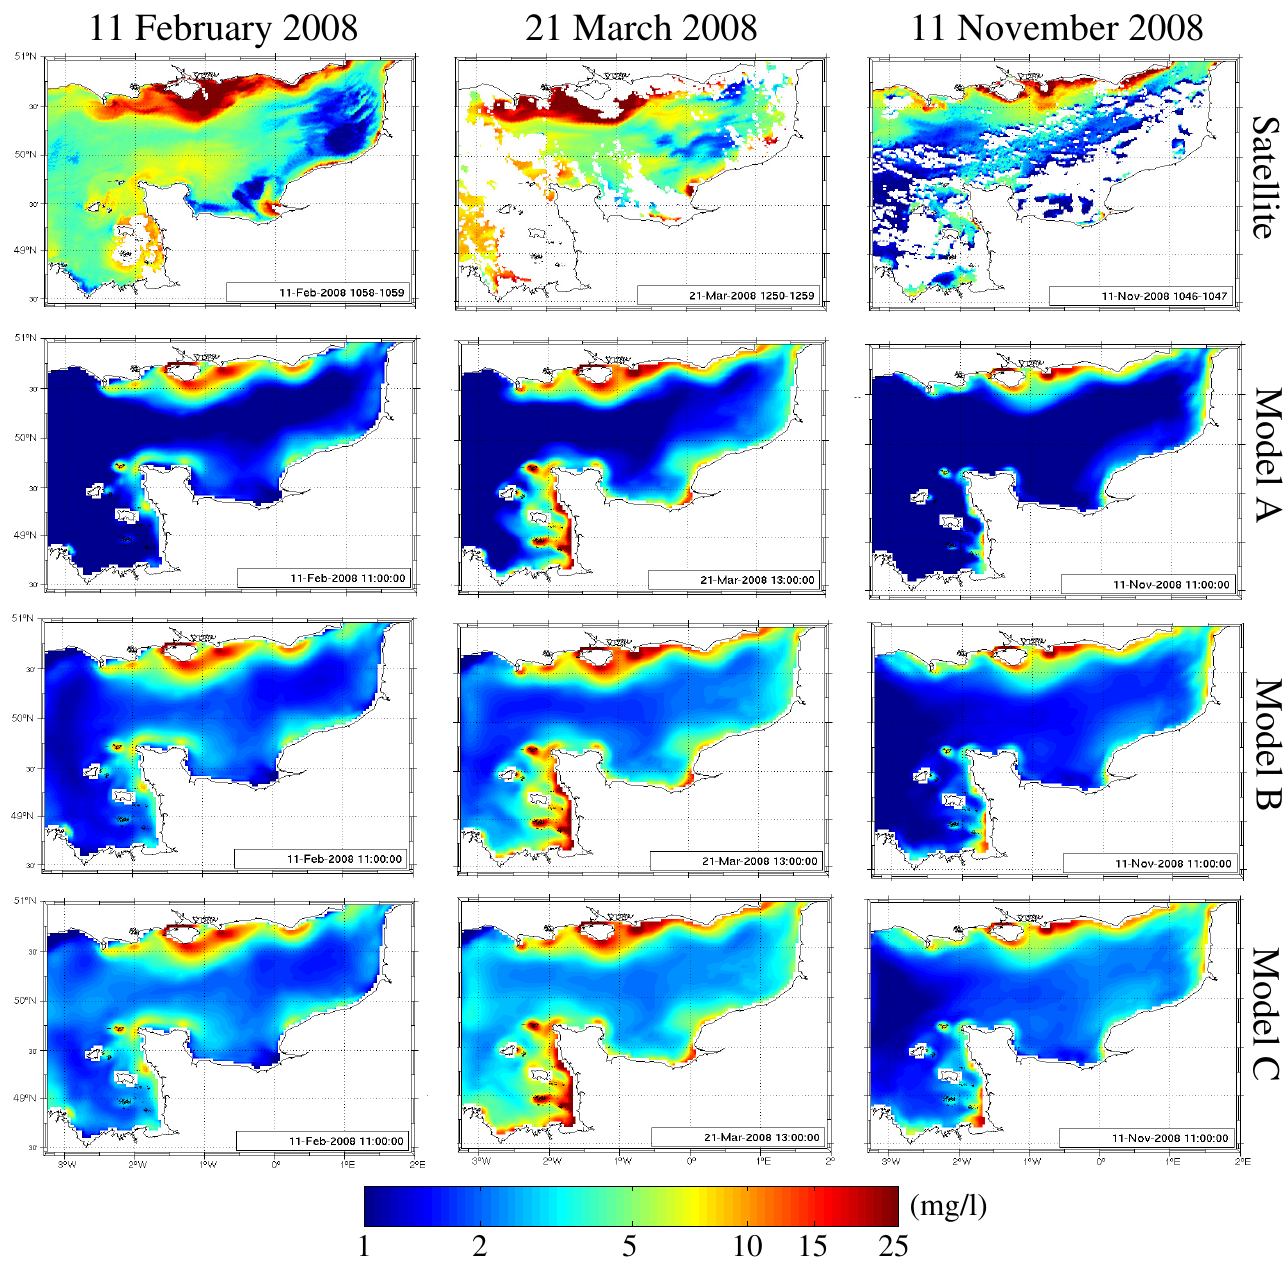
Figure 8. Near-surface SSC observed and computed in Configurations A, B and C for stormy wave conditions and spring (11 February and 21 March 2008, MERIS and MODIS) and mean (11 November 2008, MERIS)